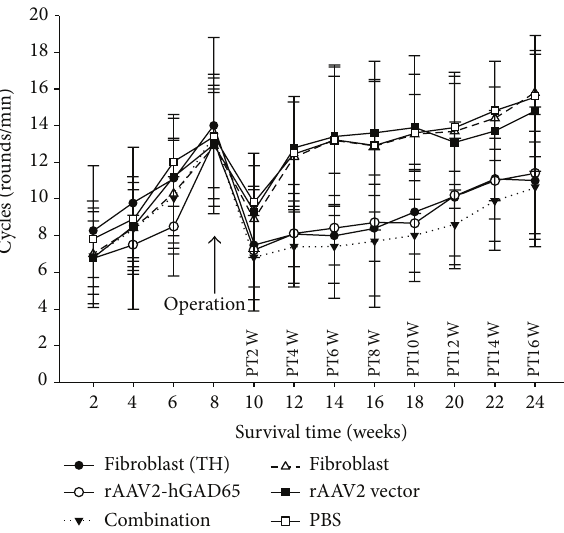
Figure 4: Quantification of tyrosine hydroxylase-positive cells in the SNc and VTA. There was no statistical difference in the number of tyrosine hydroxylase-positive cells in the SNc and VTA between the subgroups of fibroblasts (TH), rAAV2-hGAD65, and combination at 4, 8, and 16 weeks after treatment ( 𝑃 > 0.05 , 𝑛 = 6 ). At the same time, there was no statistical difference in the number of the TH-positive neurons in these three groups and the three control groups (fibroblasts, rAAV2 vector, and PBS) ( 𝑃 > 0.05 , 𝑛 = 6 ). There was a decreasing tendency of TH-positive neurons of SNc and VTA of all six groups from 4 weeks to 16 weeks after treatment. Fibroblasts (TH), fibroblasts transferred by rAd-TH; fibroblasts, the primary cultured fibroblasts; rAAV2-hGAD65, recombinant adeno-associated virus particles containing human glutamic acid decarboxylase 65; rAAV2 vector, control adeno-associated virus pedicles; combination, rAAV2-hGAD65 + fibroblasts (TH); PBS, inject the PBS into the